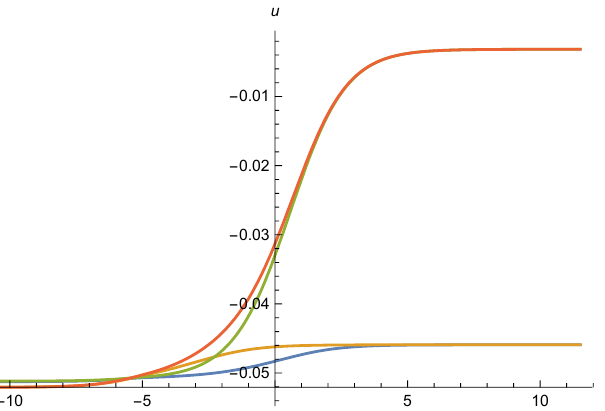
Figure 17. Effective potential u as function of x = ln ˜ ρ . The two upper curves are for g 2 /4 π = y 2 /4 π = 1/40. The red curve corresponds to ξ ∞ = 1.0, the green curve to ξ ∞ = 0.05. The two lower curves are for g 2 = y 2 = 0, with the orange curve for ξ ∞ = 1.0 and the blue curve for ξ ∞ = 0.05. Particle numbers are N S = 4, N V = 12, and N F = 45 and initial conditions are set at ˜ ρ as = 5000.